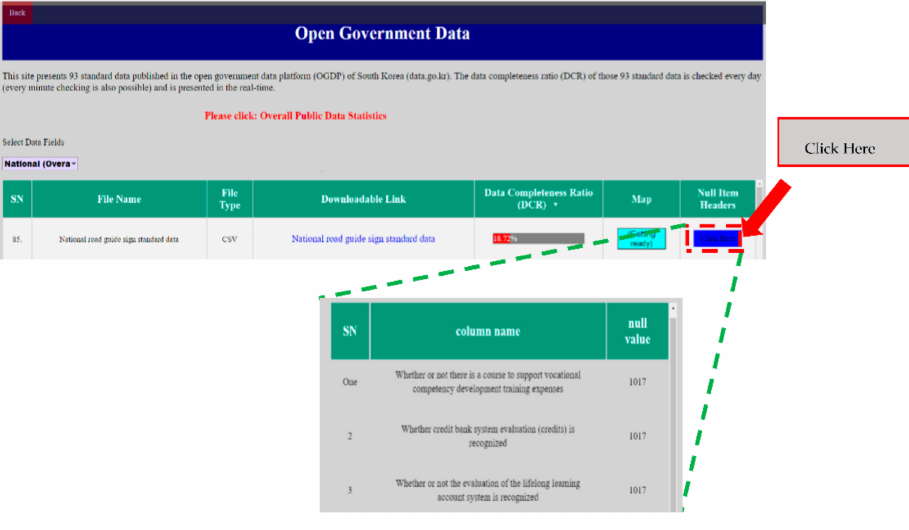
Figure 14. Dashboard showing headers of a file whose row is empty, along with their